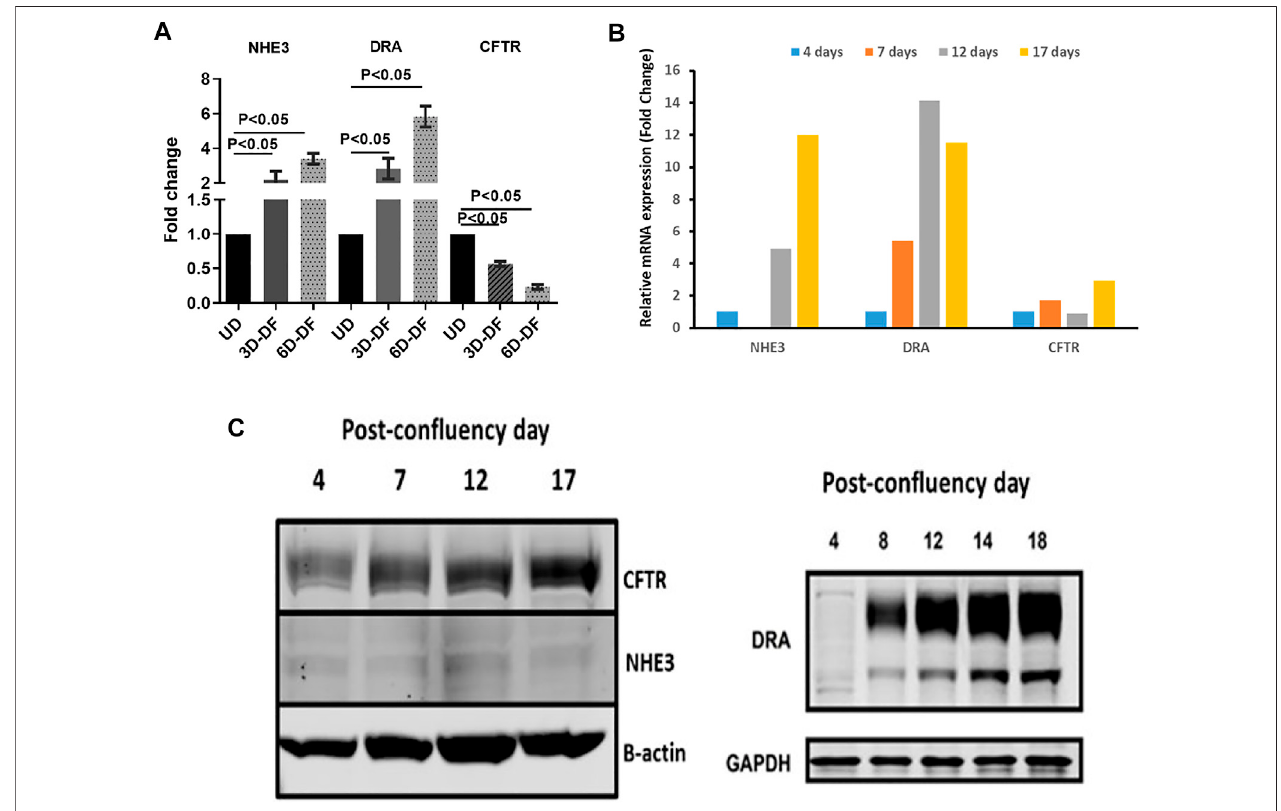
FIGURE 2 | (A) . Differentiation-dependent protein expression of NHE3, DRA, and CFTR in human enteroids. n = 3 (paired t-tests). Similar time-dependent mRNA (B) and protein (C) expression of NHE3, DRA, and CFTR in Caco-2-BBe monolayers with days post con fl uency.